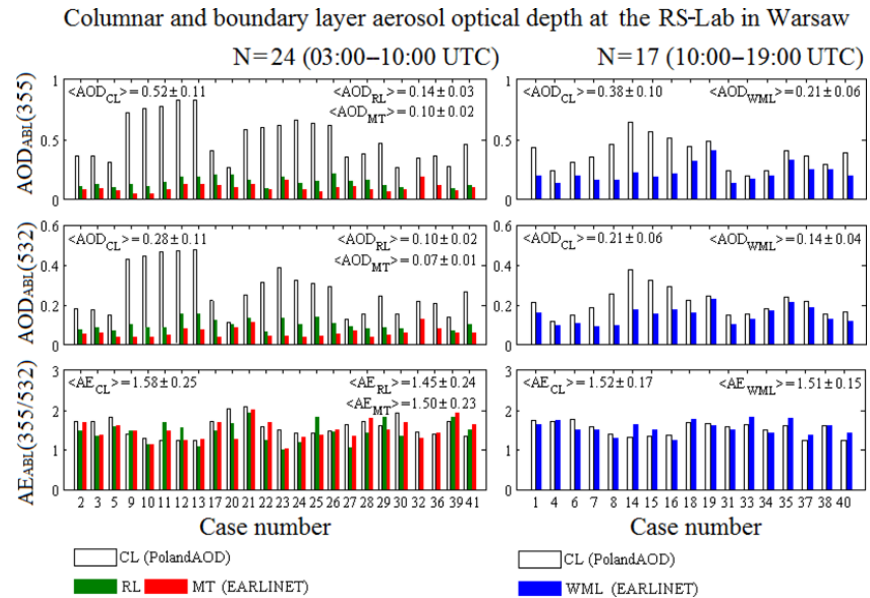
Figure 4. Hourly averages of the aerosol optical depth (AOD) and the Ångström exponent (ÅE) derived within the atmospheric boundary layer at 355 and 532nm from the PollyXT lidar at the EARLINET/ACTRIS site, Warsaw, plotted along with the corresponding MFR-7 shadowband radiometer values from the PolandAOD-NET site, Warsaw, for July–September 2013, 2015, and 2016 (leap year). These were co-located measurements at the RS-Lab in Warsaw. The AOD CL from the MFR-7 measurements at 415 and 500nm were scaled to 355 and 532nm using the Ångström power